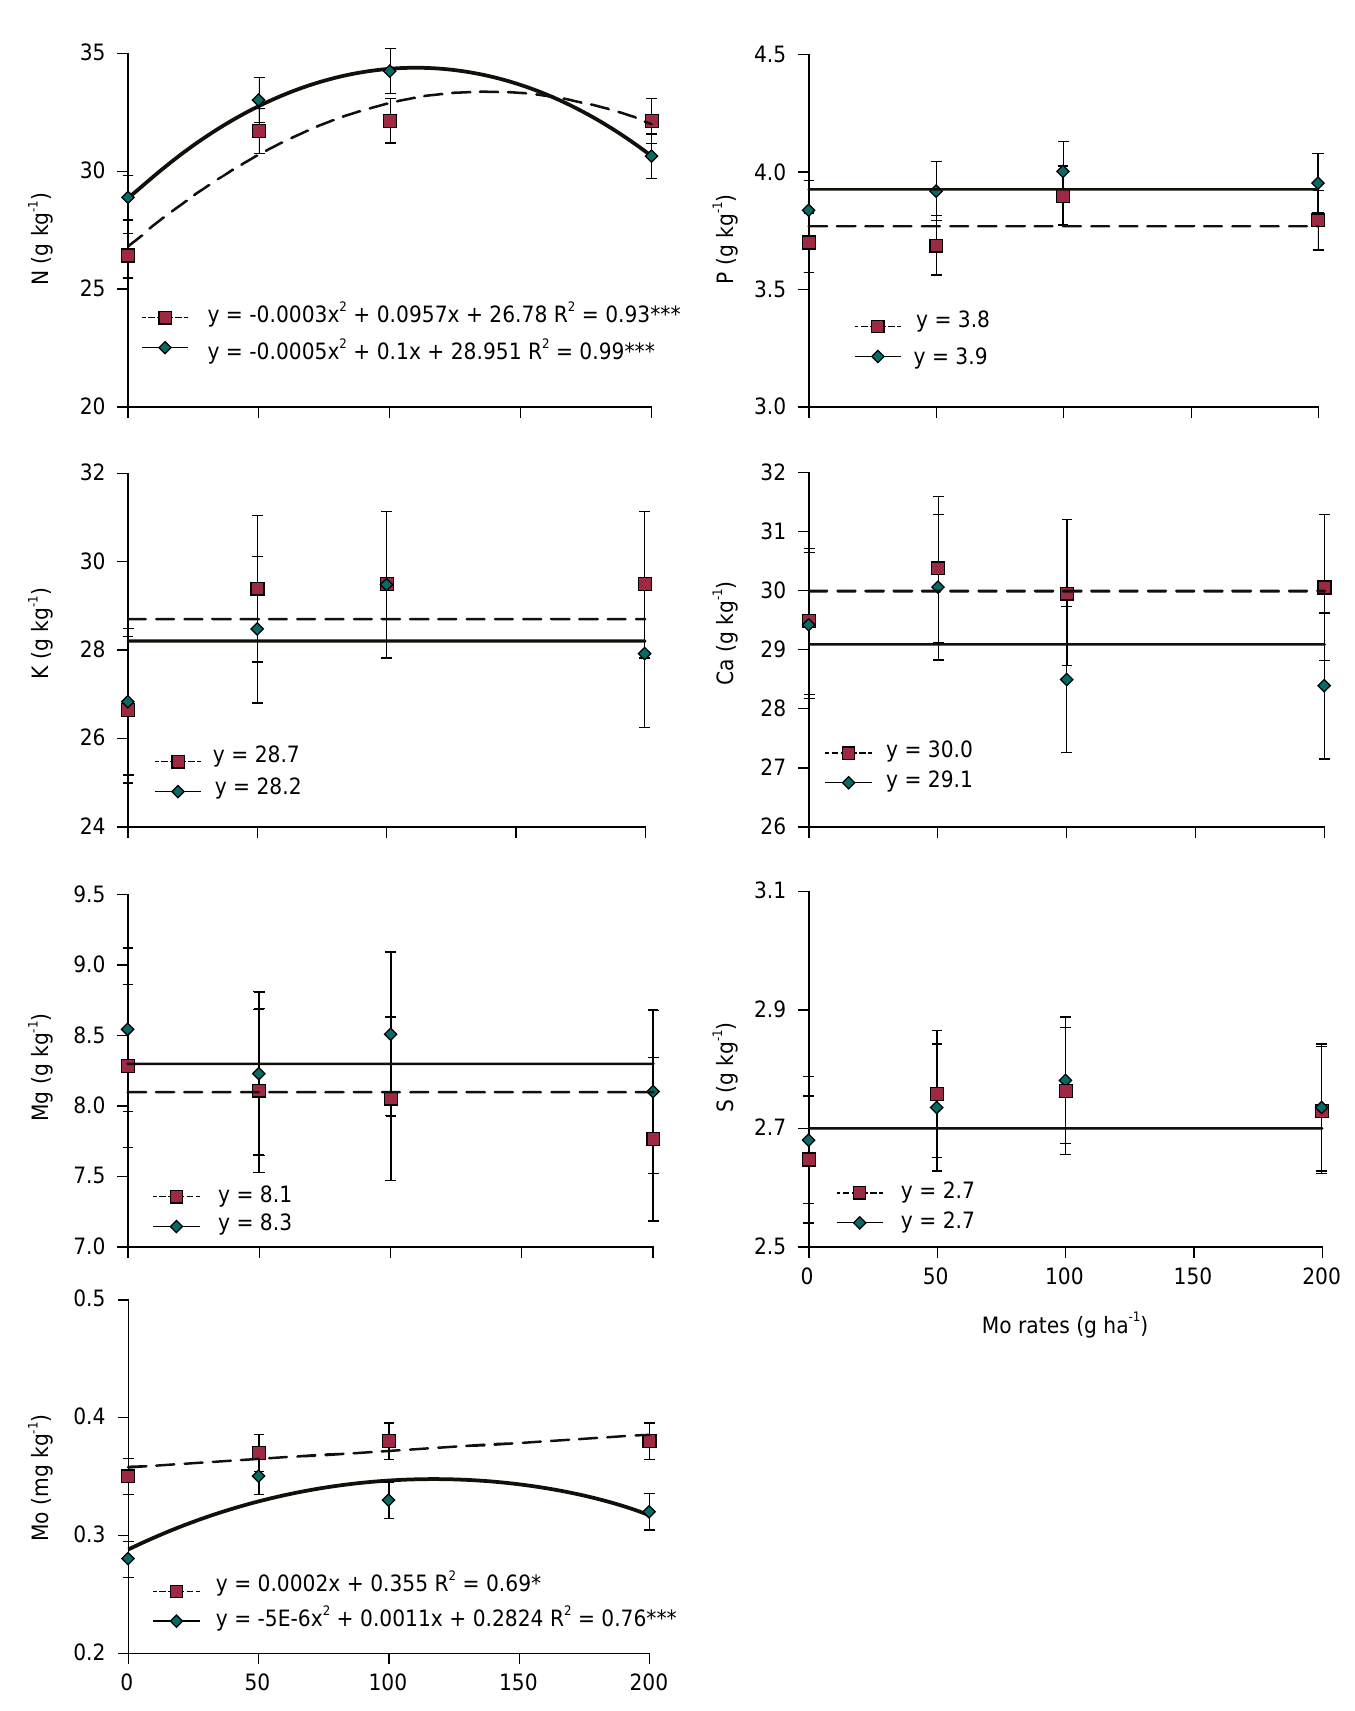
Figure 3. Nitrogen, phosphorus, potassium, calcium, magnesium, sulfur, and molybdenum contents in peanut leaves at the full flowering stage of peanut as a function of Mo rate and rhizobial inoculation [without (□) and with (♦) inoculation]. ***, **, and * are significant at p<0.01, p<0.05, and p<0.10,